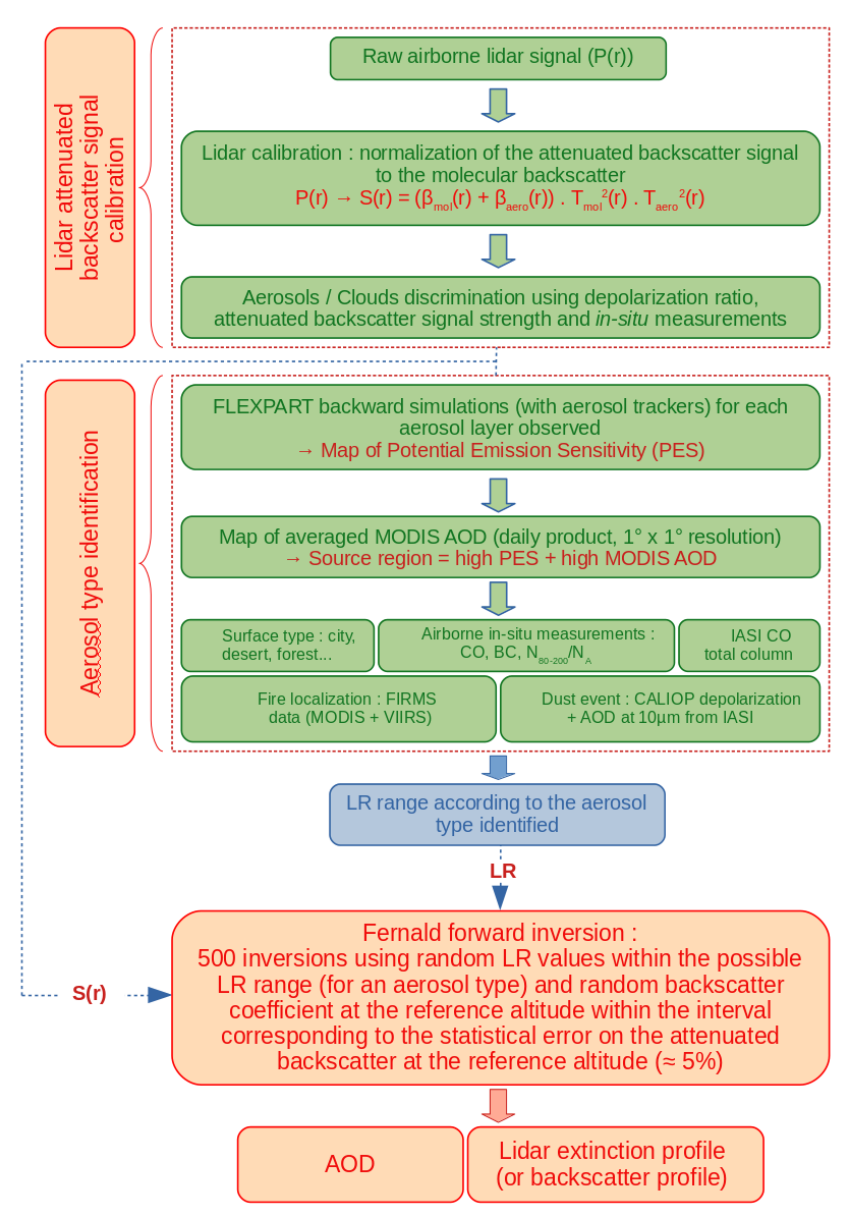
Figure 2. Flow chart of airborne lidar data processing and aerosol types